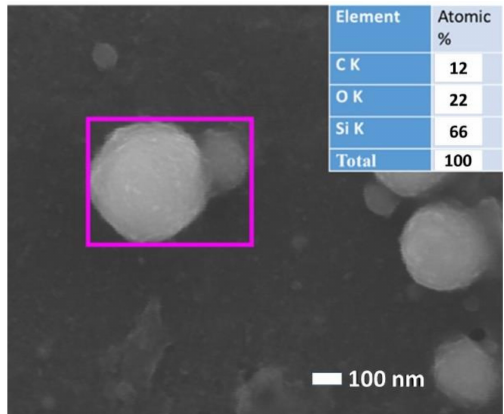
Figure 10. Top-view SEM image of silicon NPs prepared by ns-laser ablation of bulk Si in water. Inset: EDX data in the element content table.